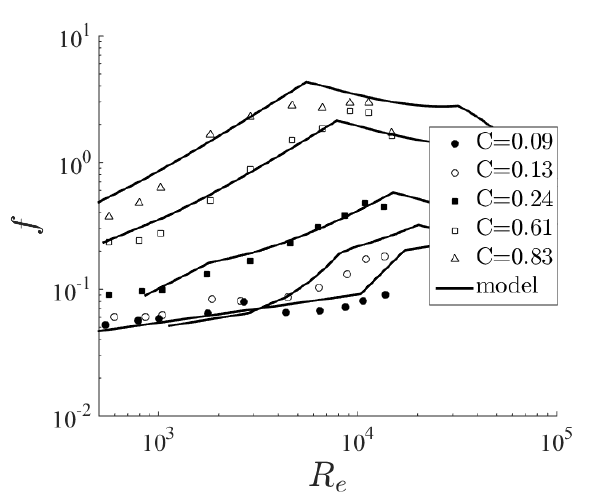
Figure 10. Friction factor as a function of Reynolds number compared with the experiments of [23] (cobbles). The diameter and height are equal to the mean diameter D = k = 0.2